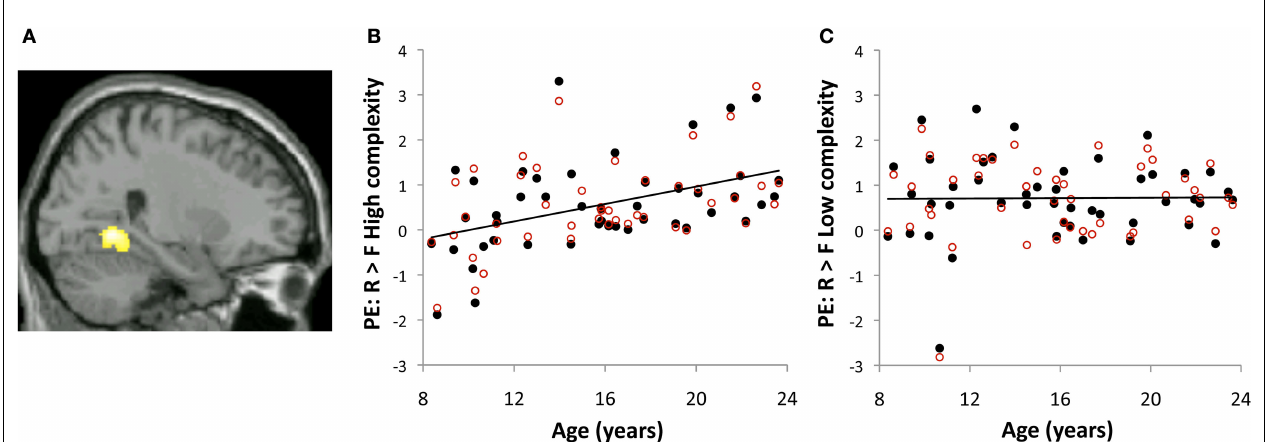
FIGURE 2 | Activations associated with successful memory formation for high- and low- complexity scenes in posterior parahippocampal gyrus. (A) Axial brain image depicting right posterior parahippocampal ROI defi ned by increase in activation with age for high > low complexity scenes. Image corresponds to MNI × coordinate 26. (B, C) Plots of correlations of the